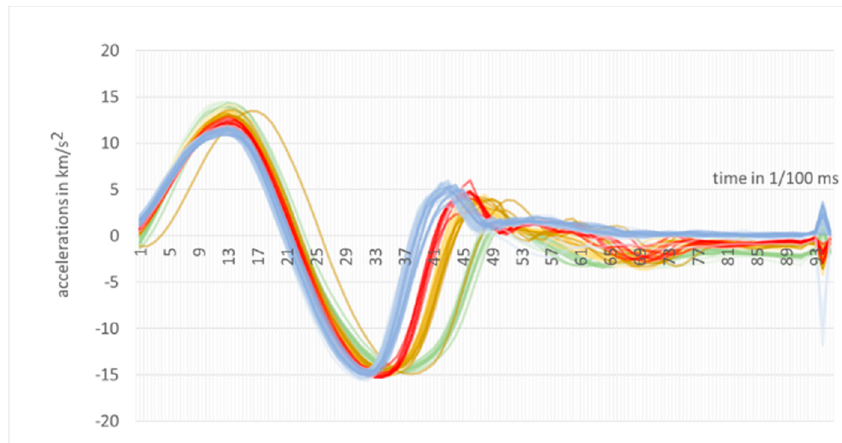
Figure 9. All accelerations of 67 tests, measured in 95 moments (in each test).